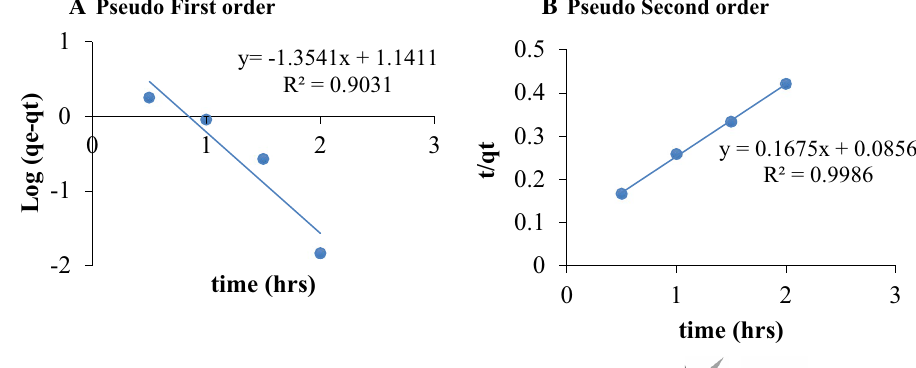
y= -1.3541x + 1.1411 R² =